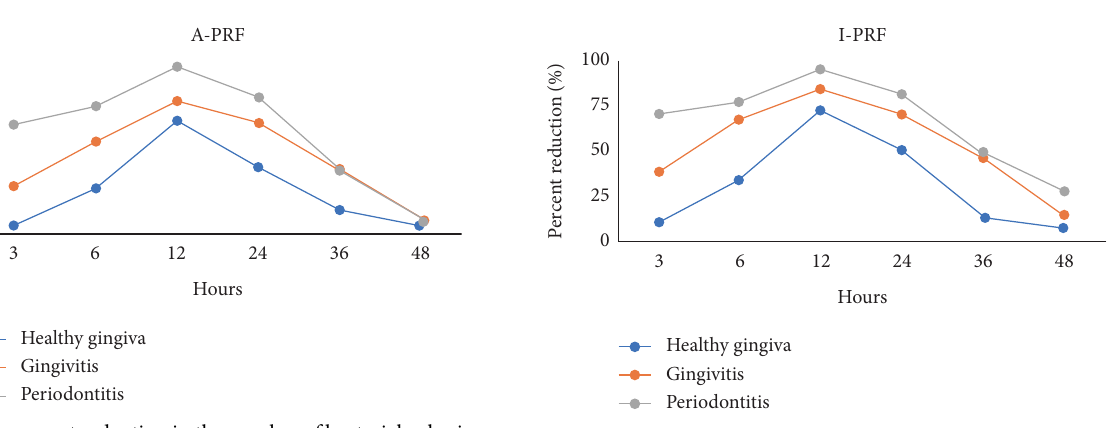
Figure 2: Te percent reduction in the number of bacterial colonies compared to the control under the infuence of I-PRF from the three groups at 3, 6, 12, 24, 36, and 48